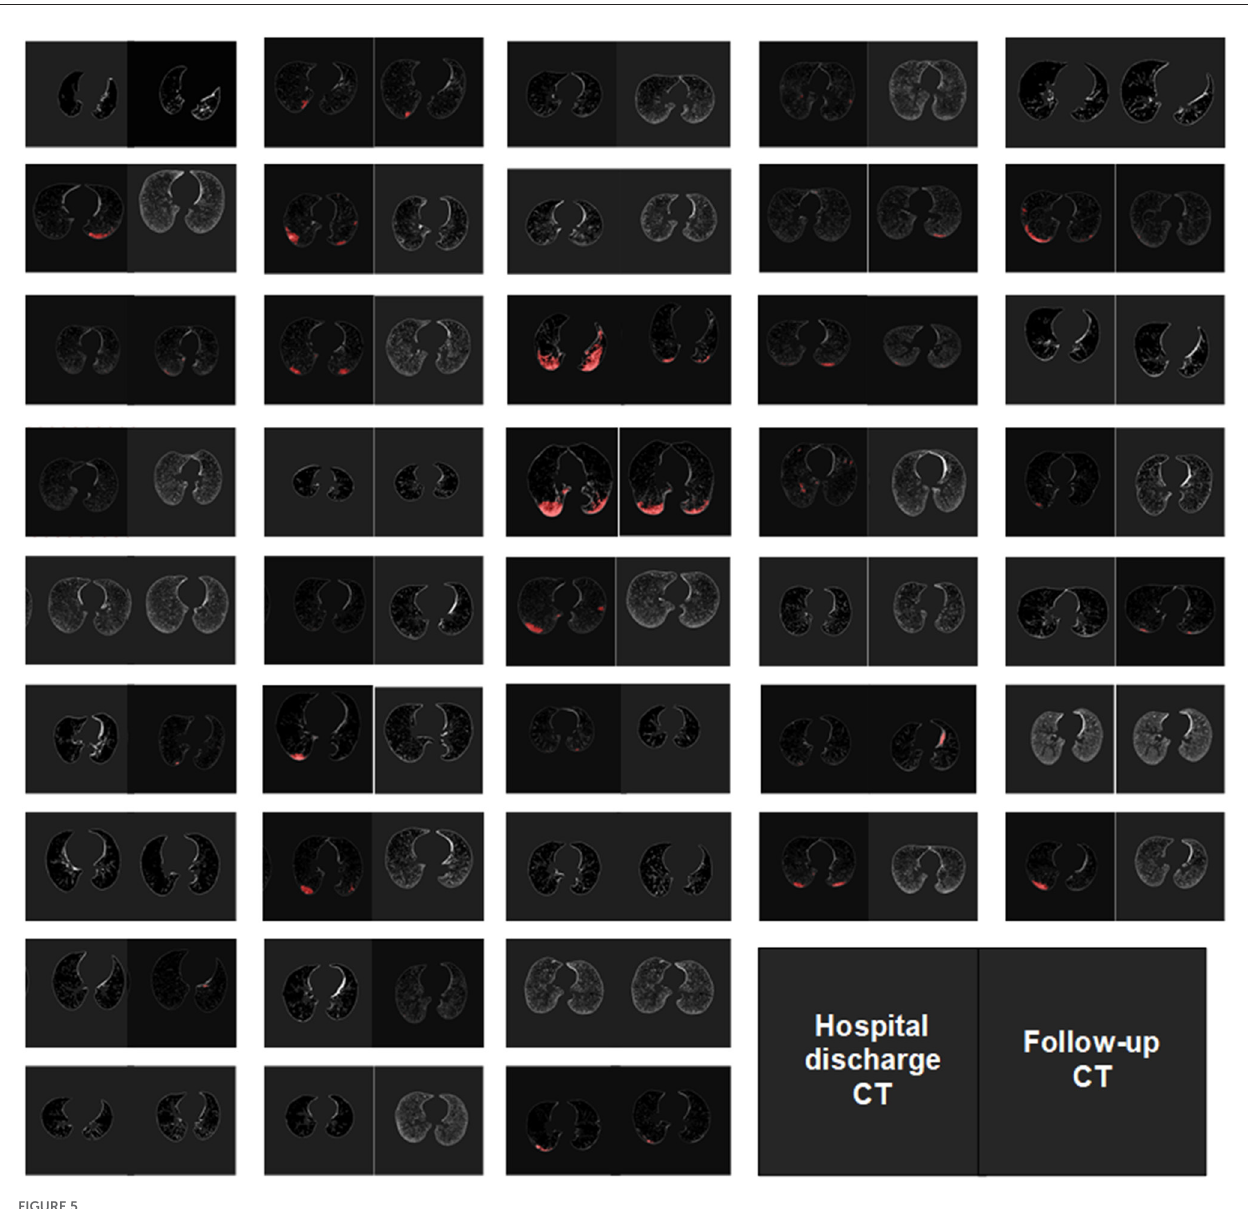
FIGURE5 DLPE method applications in 41 patients.